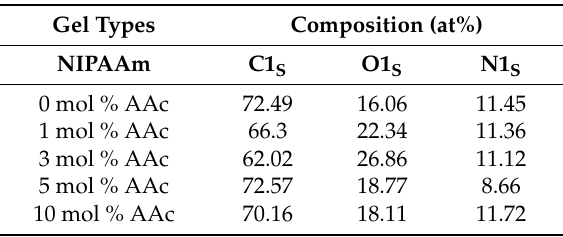
Figure 5. Electron spectroscopy for chemical analysis (ESCA) spectra of ( a ) HMDSZ-treated (20 W, 20 min, 60 mtorr), and ( b ) Poly (NIPAAm/10 mol % AAc) composite hydrogels grafted onto a HMDSZ-treated substrate. Table 2. Atomic concentration of Poly (NIPAAm/AAc) composite hydrogels grafted onto the HMDSZ-treated substrate. Values obtained by ESCA.